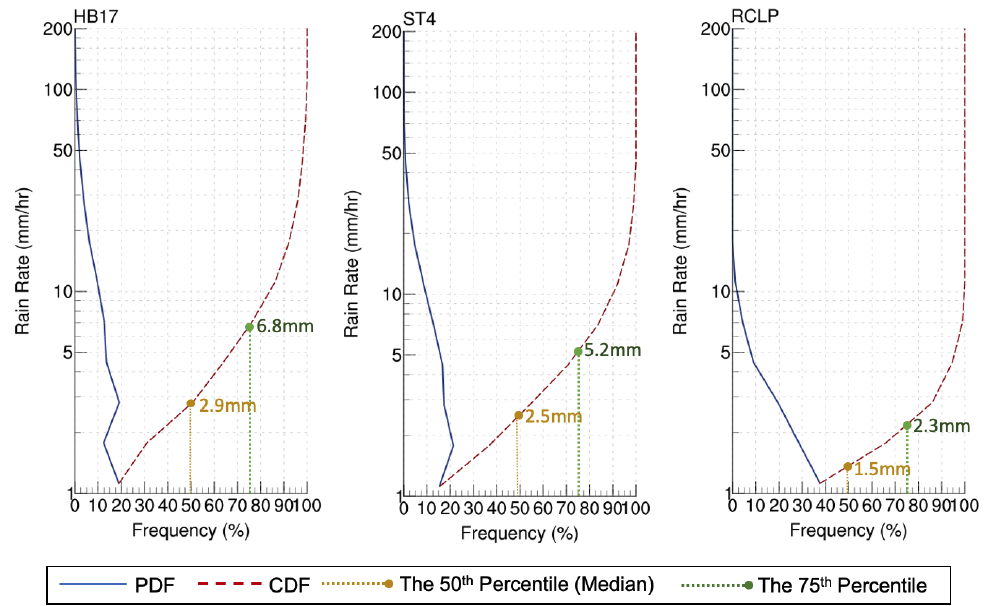
Figure 9. Probability distribution functions (PDF) and CDF of decibel rain rates (dBR). The blue line is PDF and the dashed red line is CDF. The 50th percentile of CDF is indicated via yellow points and the 75th percentile via green points. From the left to the right panel, the results are from HB17, Stage IV, and R-CLIPER sequentially.